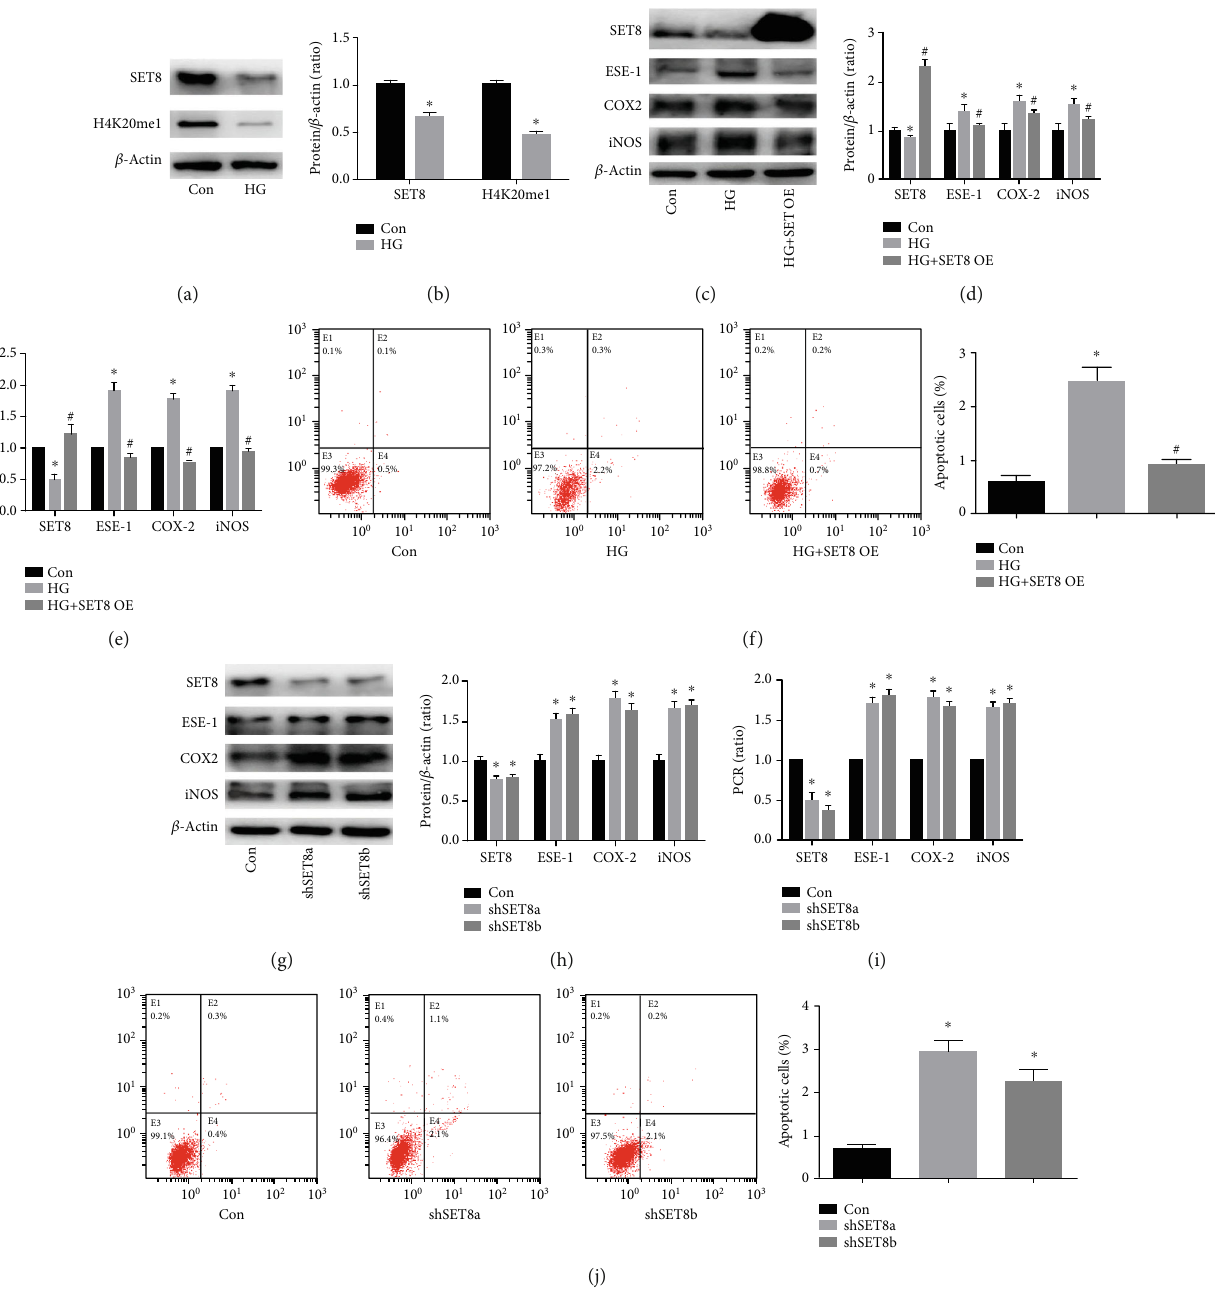
Figure 2: SET domain-containing protein 8 (SETD8) overexpression counteracted high glucose-induced cyclooxygenase 2 (COX2) and inducible nitric oxide synthase (iNOS) expression in human umbilical vein endothelial cells (HUVECs). (a, b) Western blot analysis of SETD8 and H4K20me1 in HUVECs cultured under normal or high glucose conditions. Compared with the control group, high glucose treatment decreased SETD8 and H4K20me1 protein expression in HUVECs. (c, d) Western blot analysis of SETD8, E26 transformation- speci fi c sequence transcription factor-1 (ESE-1), iNOS, and COX2 in HUVECs overexpressing SETD8 under high glucose conditions. SETD8 overexpression inhibited ESE-1, iNOS, and COX2 protein expression in hyperglycaemic HUVECs. (e) qPCR analysis of SETD8, ESE-1, iNOS, and COX2 in HUVECs overexpressing SETD8 under high glucose conditions. SETD8 overexpression inhibited ESE-1, iNOS, and COX2 mRNA expression in hyperglycaemic HUVECs. (f) The e ff ects of SETD8 overexpression on high glucose-mediated apoptosis in HUVECs. SETD8 overexpression decreased cell apoptosis in hyperglycaemic HUVECs. (g, h) Western blot analysis of SETD8, ESE-1, iNOS, and COX2 in HUVECs upon SETD8 silencing. Compared with the control group, shSETD8 increased ESE-1, iNOS, and COX2 protein expression in HUVECs. (i) qPCR analysis of SETD8, ESE-1, iNOS, and COX2 in HUVECs upon SETD8 silencing. Compared with the control group, shSETD8 increased ESE-1, iNOS, and COX2 mRNA expression in HUVECs. (j) Cell apoptosis analysis in HUVECs upon SETD8 silencing. Compared with the control group, shSETD8 increased cell apoptosis in HUVECs. SETD8 OE: SETD8 overexpression; shSETD8: short hairpin RNA SETD8. ∗ P < 0 : 05 , compared with the control group; # P < 0 : 05 , compared with high glucose